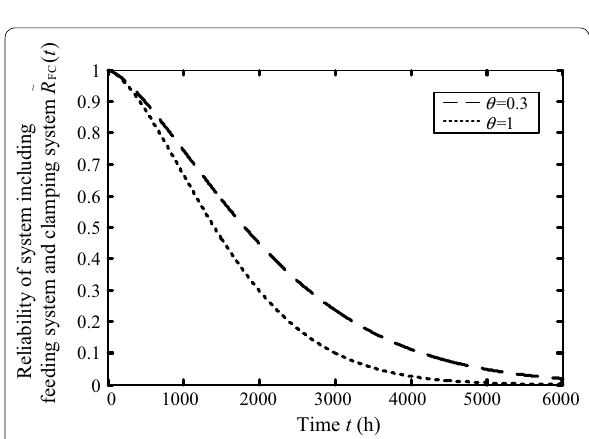
Figure 3 Changing situation of ˜ R FC ( t ) along with